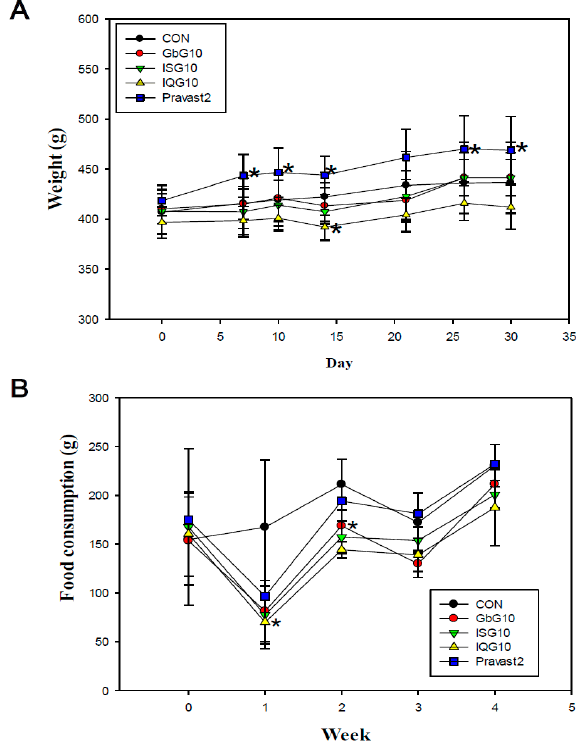
Figure 1. ( A ) Effect of IQG: B . ignitus glycosaminoglycan on body weight in high fat (HFD, 60%) diet rats over one month. GbG10: G . bimaculatus glycosaminoglycan 10 mg/kg. ISG10: I . sinclairii glycosaminoglycan 10 mg/kg. IQG10: B . ignitus glycosaminoglycan 10 mg/kg. Pravast2: Pravastain 2 mg/kg. * p < 0.05, compared with the control (HFD only) group. ( B ) Food consumption changes in rats treated with IQG on a high fat diet. * p < 0.05, compared with control (HFD only) group.